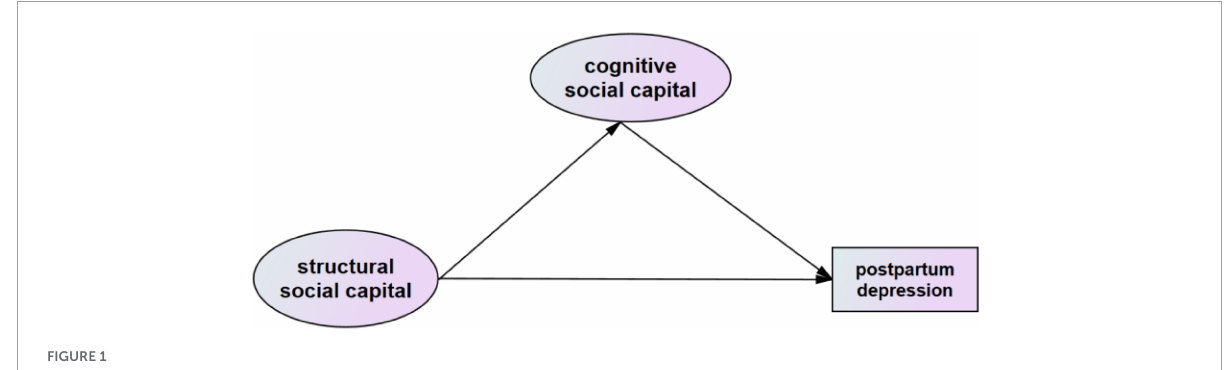
FIGURE1 Conceptual